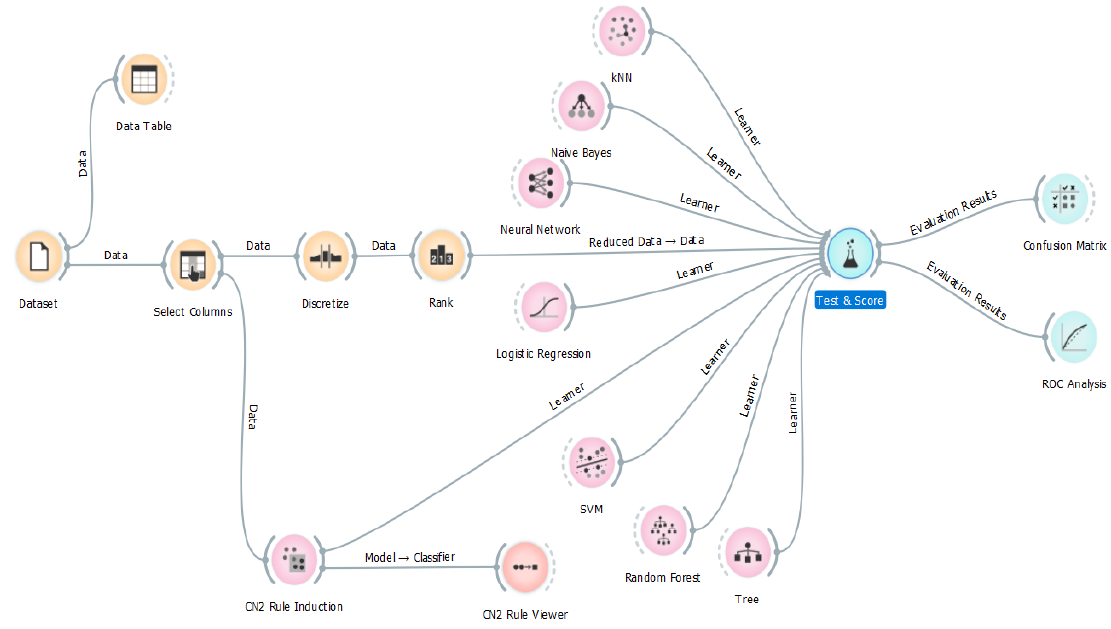
Figure 4. Data mining process.